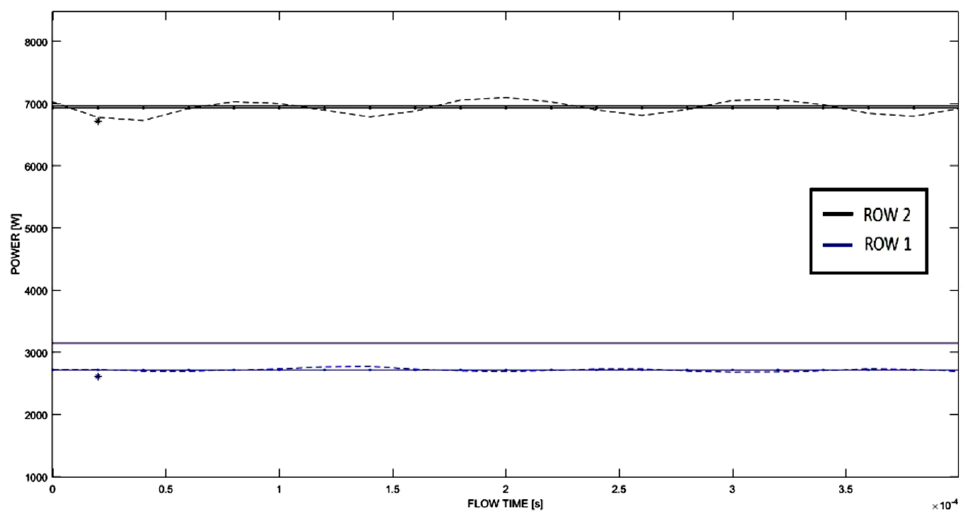
Figure 16. Output power as a function of time.